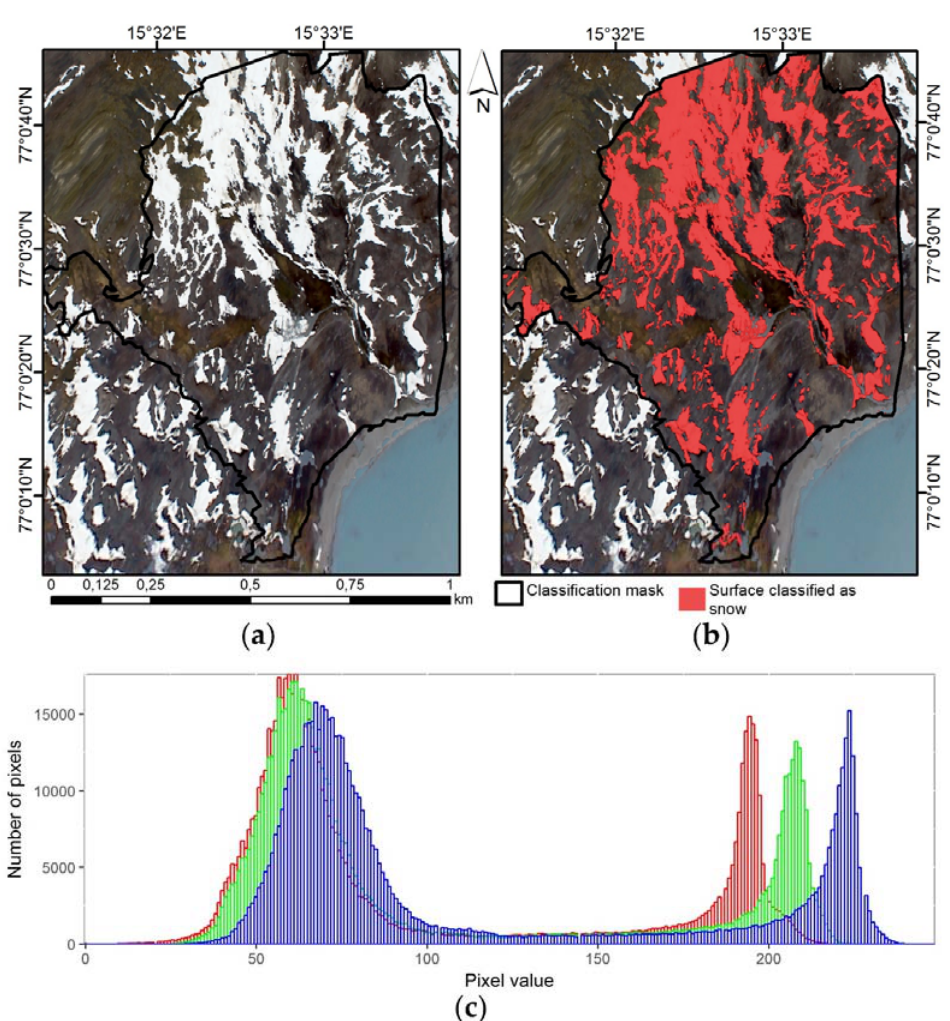
Figure 4. Classification example for 5 June 2016. ( a ) Orthoimage zoomed to classification area; ( b ) Classification result with threshold value in blue band set to 140; ( c ) Frequency histogram of RGB values with characteristic bimodal distribution—note that the distance between modal values is largest for the blue band.